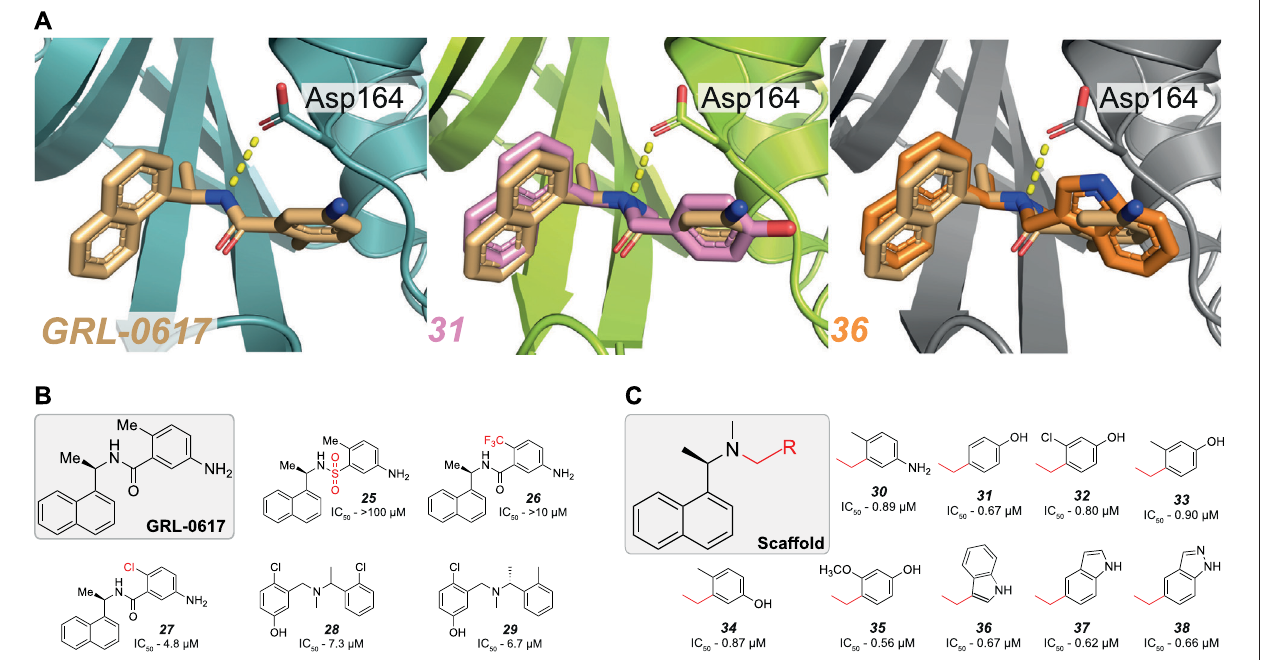
FIGURE 5 | Modi fi cation of the amide bond in GRL-0617 . (A) Close up view of the binding pocket for GRL-0617, 31 (PDB 7SDR) and 36 (PDB 7RZC) . PLpro is represented in teal, lime green or grey respectively in cartoon representation and the inhibitors are shown in wheat, pink, or orange respectively in ball-and-stick representation. In GRL-0617 the side chain of Asp164 forms a crucial H-bond interaction with the amide nitrogen and the orthomethyl group remains invariant in most derivatives, as its binding pocket restricts the orientation of the phenyl ring. In 31 and 36 the amide bond was successfully replaced with a tertiary amine and both compounds appear to have effectively removed the dependency on the orthomethyl group by increasing the bond strength with Asp164. (B) The amide bond and orthomethyl appear to be highly sensitive to variation ( 25 – 27 ). Conservative substitution with a chlorine group ( 27 ) reduces the IC 50 5-fold, to 4.8 µM. Hit compounds 28 – 29 from (Ma et al., 2021) enabled the merging of compound properties with GRL-0617. (C) Compounds explored in (Ma et al., 2021).A tertiary amine enablesmore extensive variations to the phenyl group not achieved prior, while retaining compound potency.